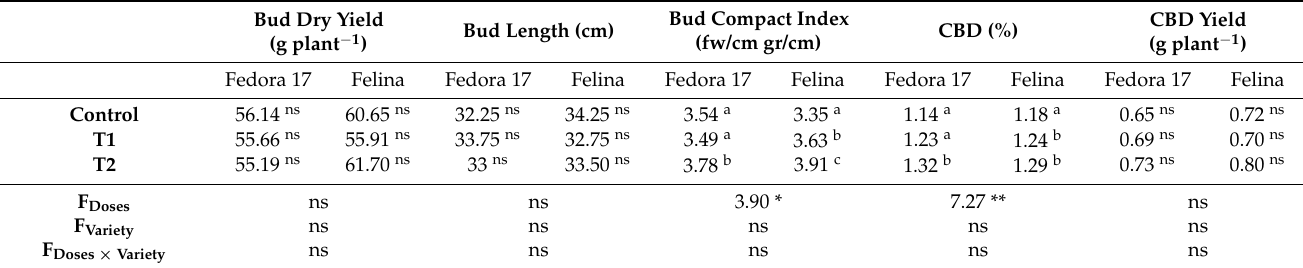
Table 4. Yield characteristics and CBD content as affected by different Trichoderma harzianum treatments in hemp varieties Fedora 17 and